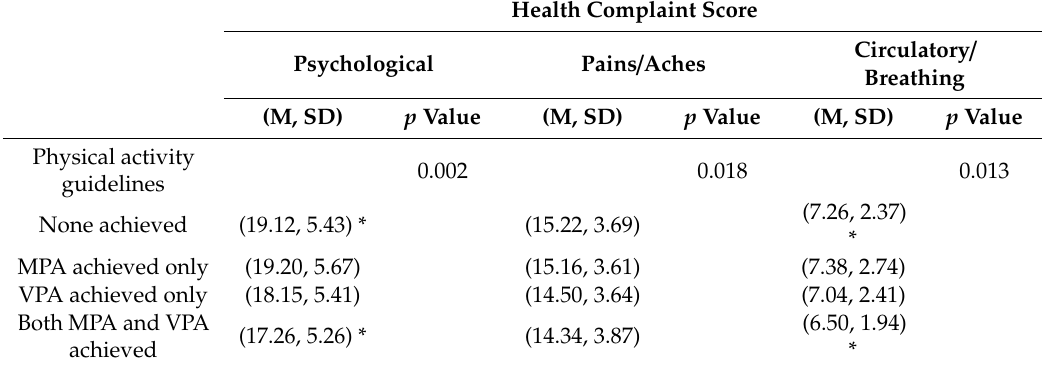
Bivariate relationships between three (mutually exclusive) categories of physical activity guidelines achievement and health complaints among undergraduates at the University of Turku,